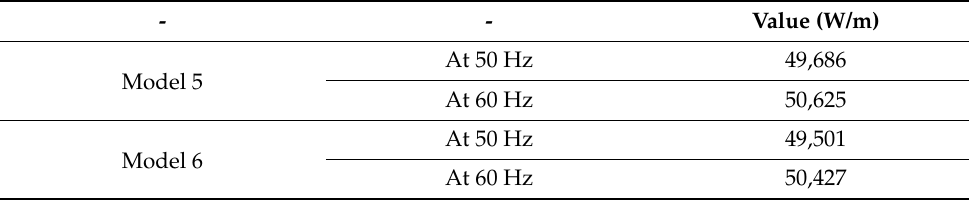
Figure 11. Magnetic flux density for at 60 Hz for: ( a ) Model 5; ( b ) Model 6. Table 9. Electromagnetic heating (losses) for circular busbar